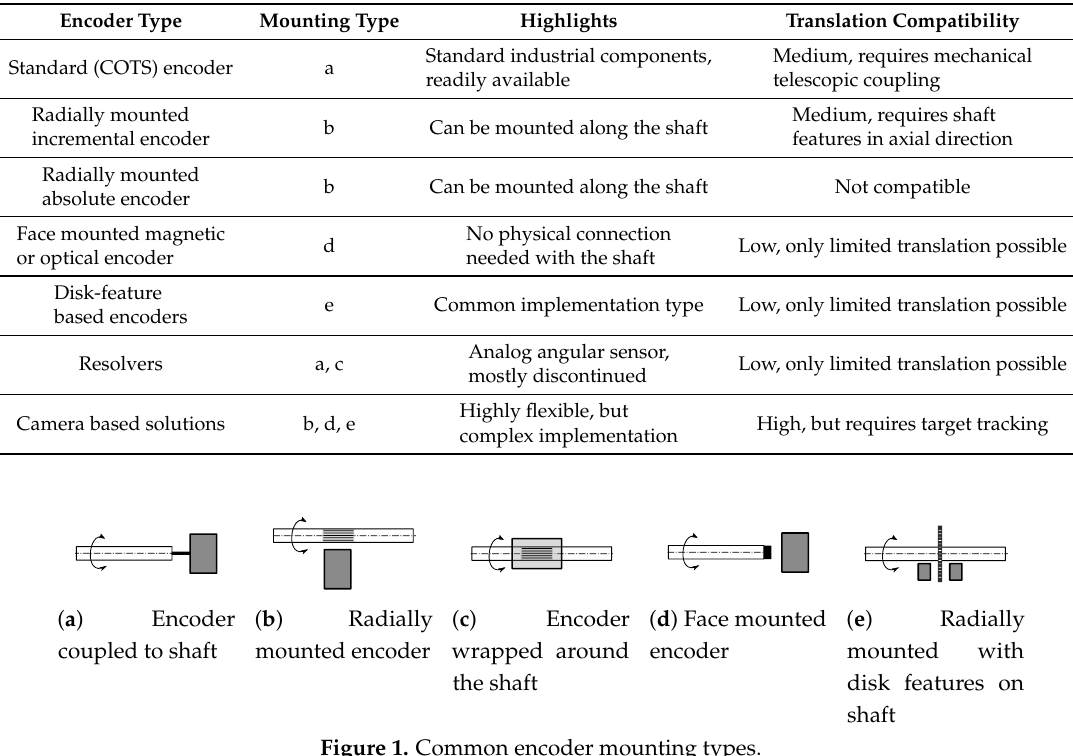
Table 1. Comparison of common encoder types in terms of mounting types (as shown in Figure 1) and translation compatibility.